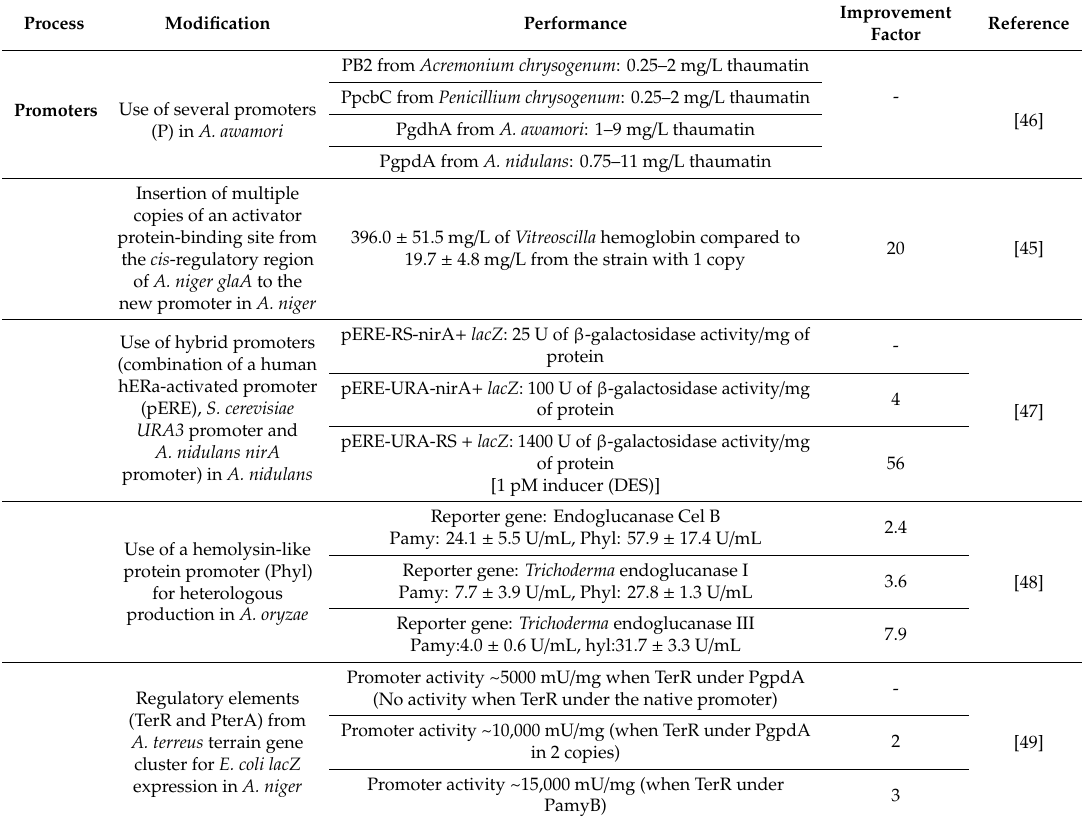
Table 2. Approaches for improving recombinant protein production through promoter